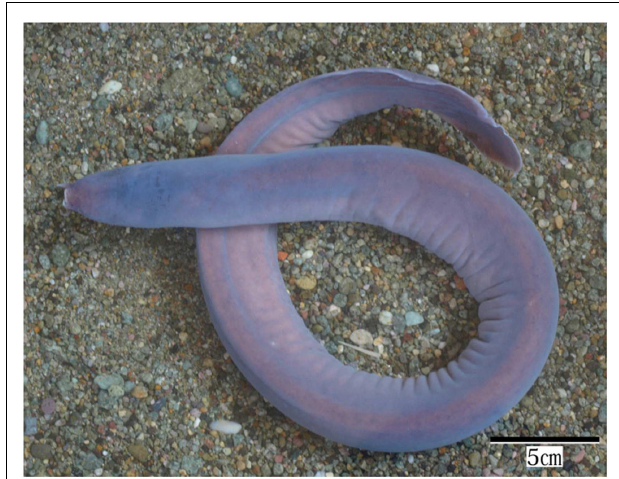
FIGURE 2 | Brown hagfish, Paramyxine atami .